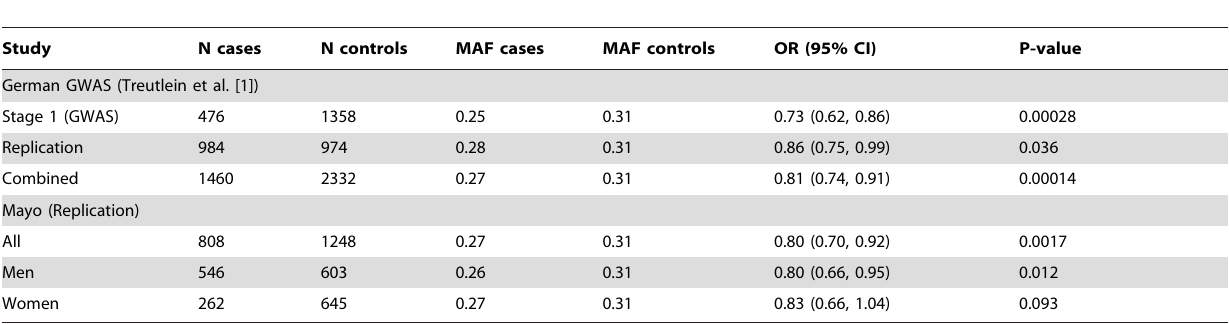
Table 2. Association of alcohol dependence with ADH1C SNP rs1614972 in the study of Treutlein et al. and our replication study, including sex-specific association.